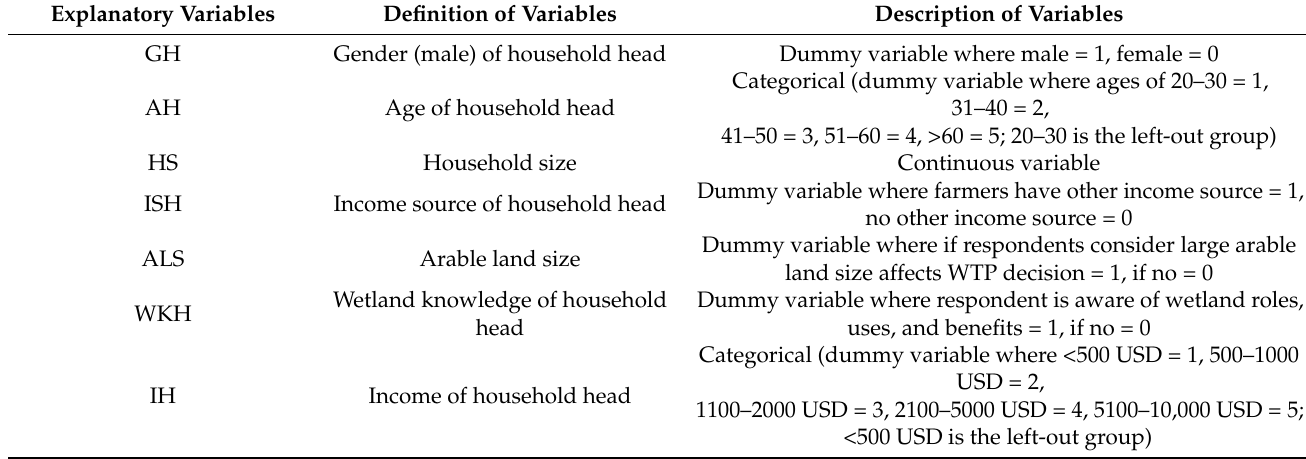
Table 1. Explanatory variables used in the ordered logistic regression